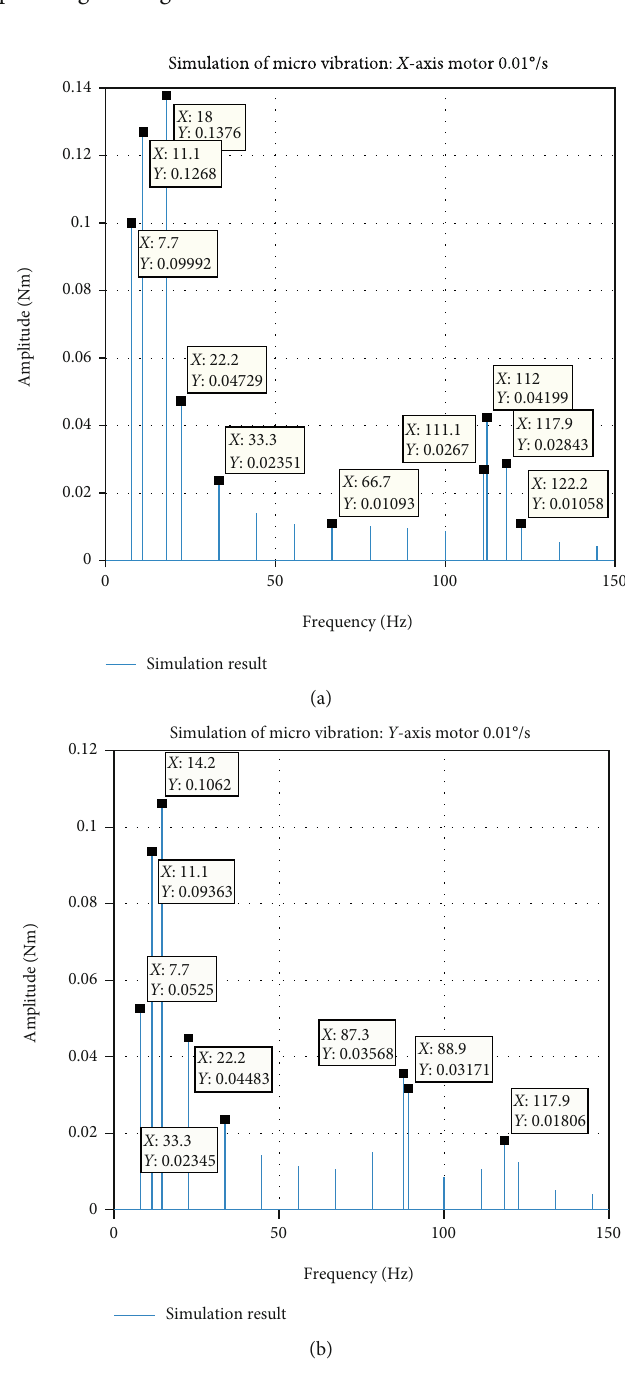
Figure 4: Simulation results of microvibration frequency domain curve: (a) x -axis motor; (b) y -axis